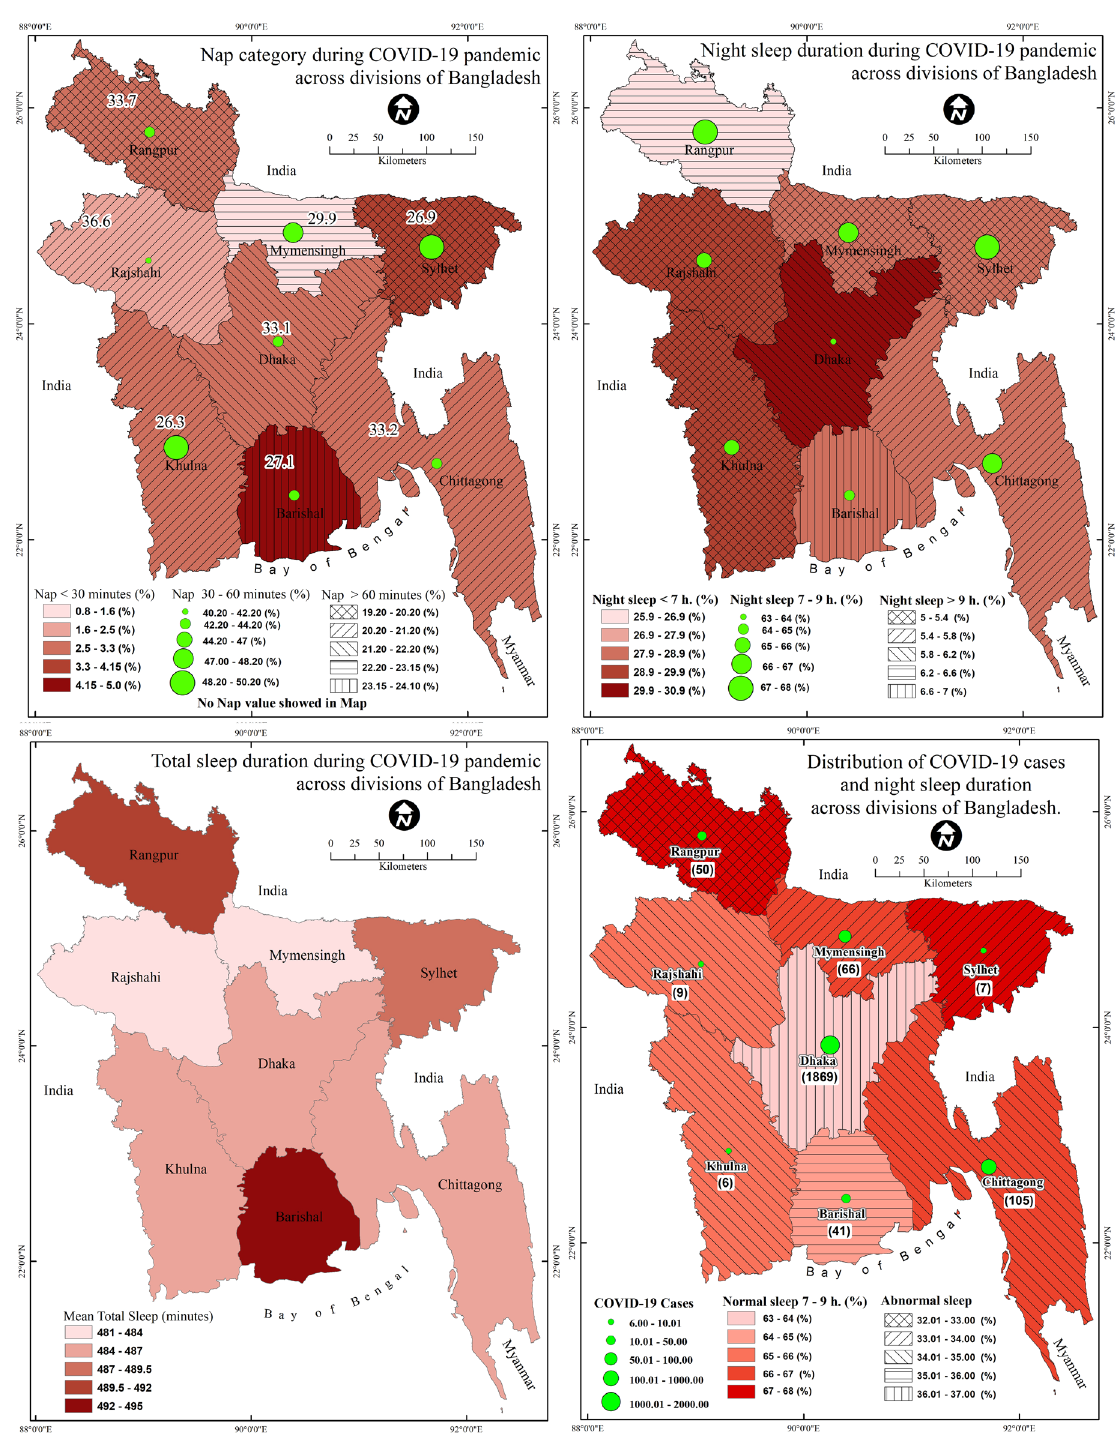
Figure 1. Sleep duration across divisions during the COVID-19 pandemic in